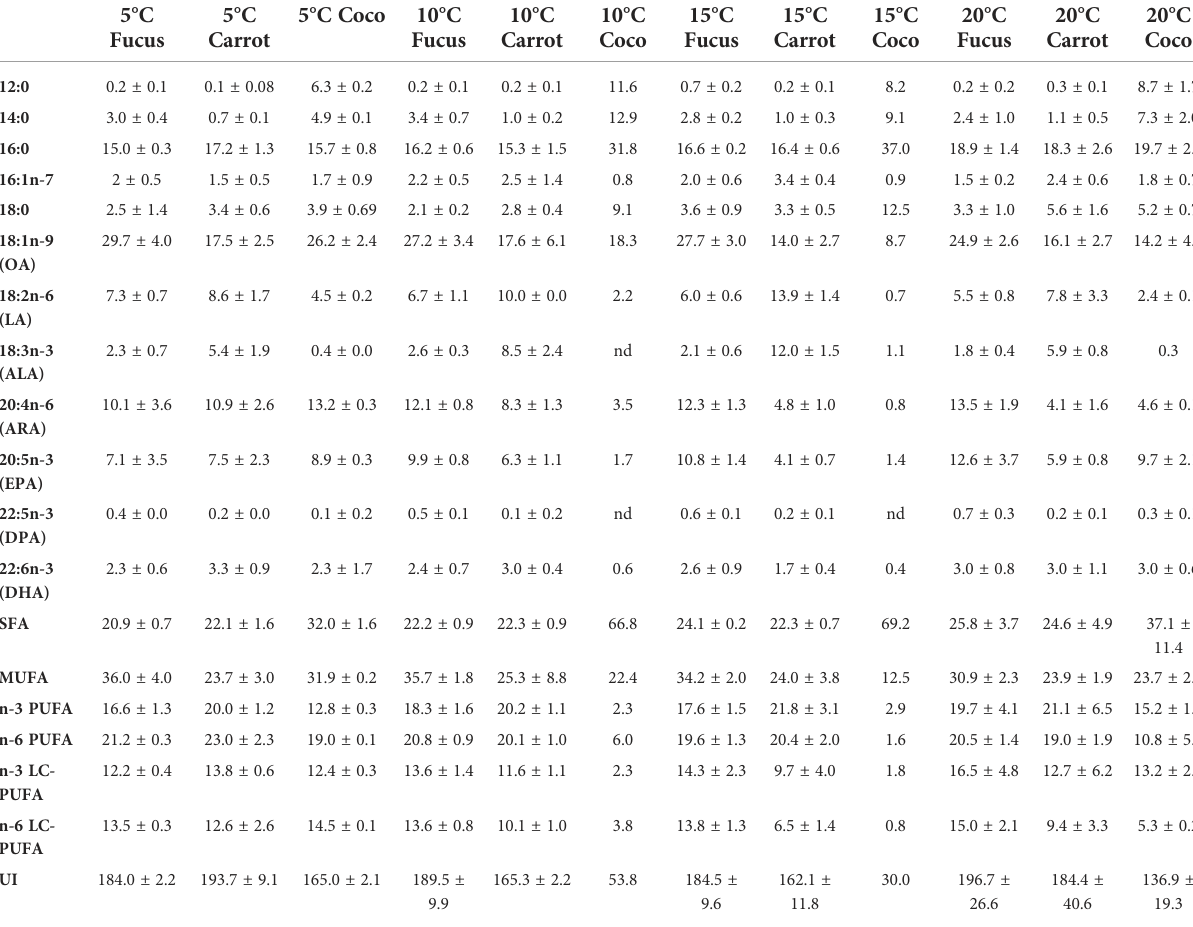
TABLE 3 Relative fatty acid (FA) composition (% of total FA) of samples of G. locusta fed different diets at four